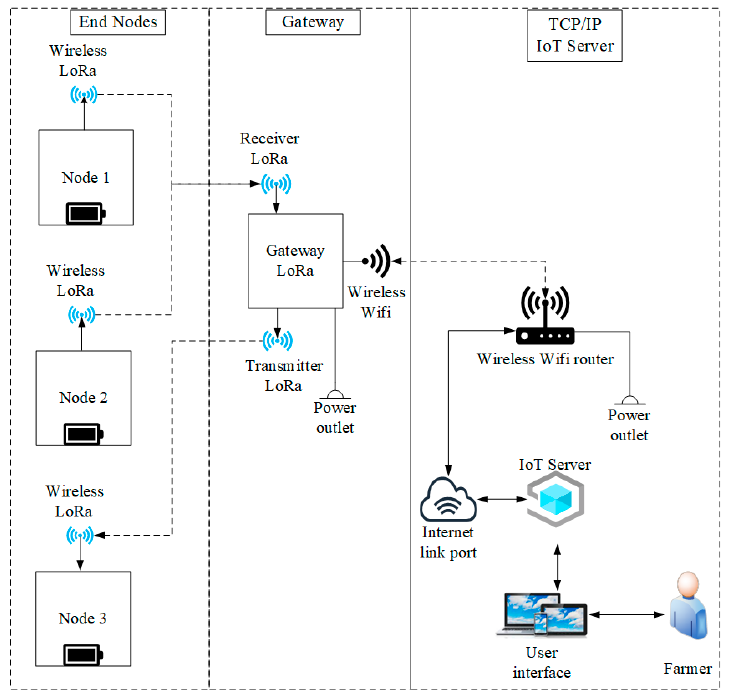
Figure 2. General architecture of the LoRa network system.